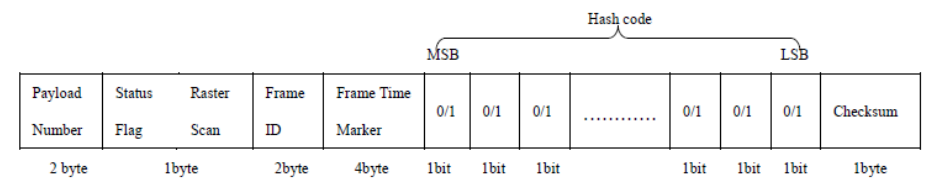
Figure 7. Hash packet